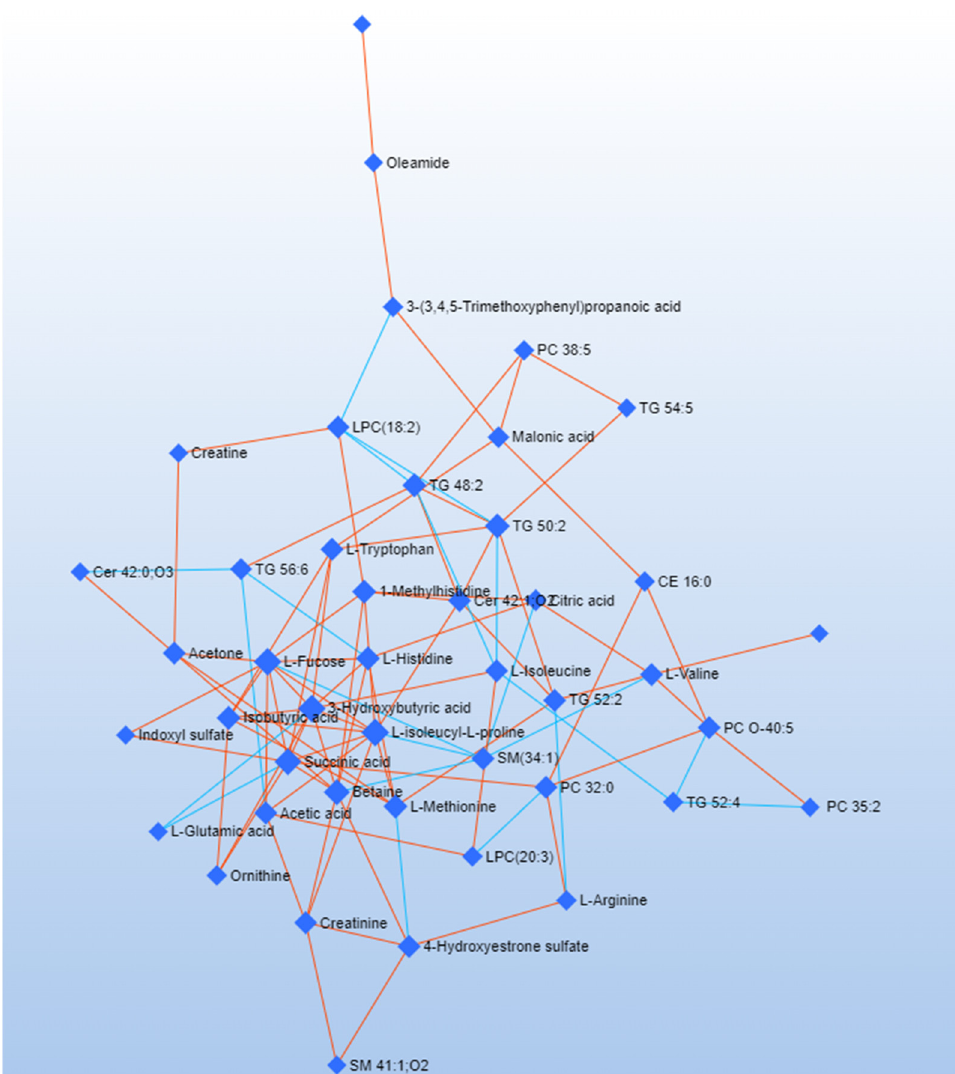
Figure 5. Correlation network obtained by DSPC algorithm using discriminating metabolites (VIP > 1) between advanced ALS patients. Nodes represent metabolites; red lines indicate a direct correlation, blue lines indicate an inverse correlation. Table 2. DSPC network analysis. Degree of node and betweenness of the interrelationships calculated on the metabolites with VIP > 1 related to the early and advanced ALS